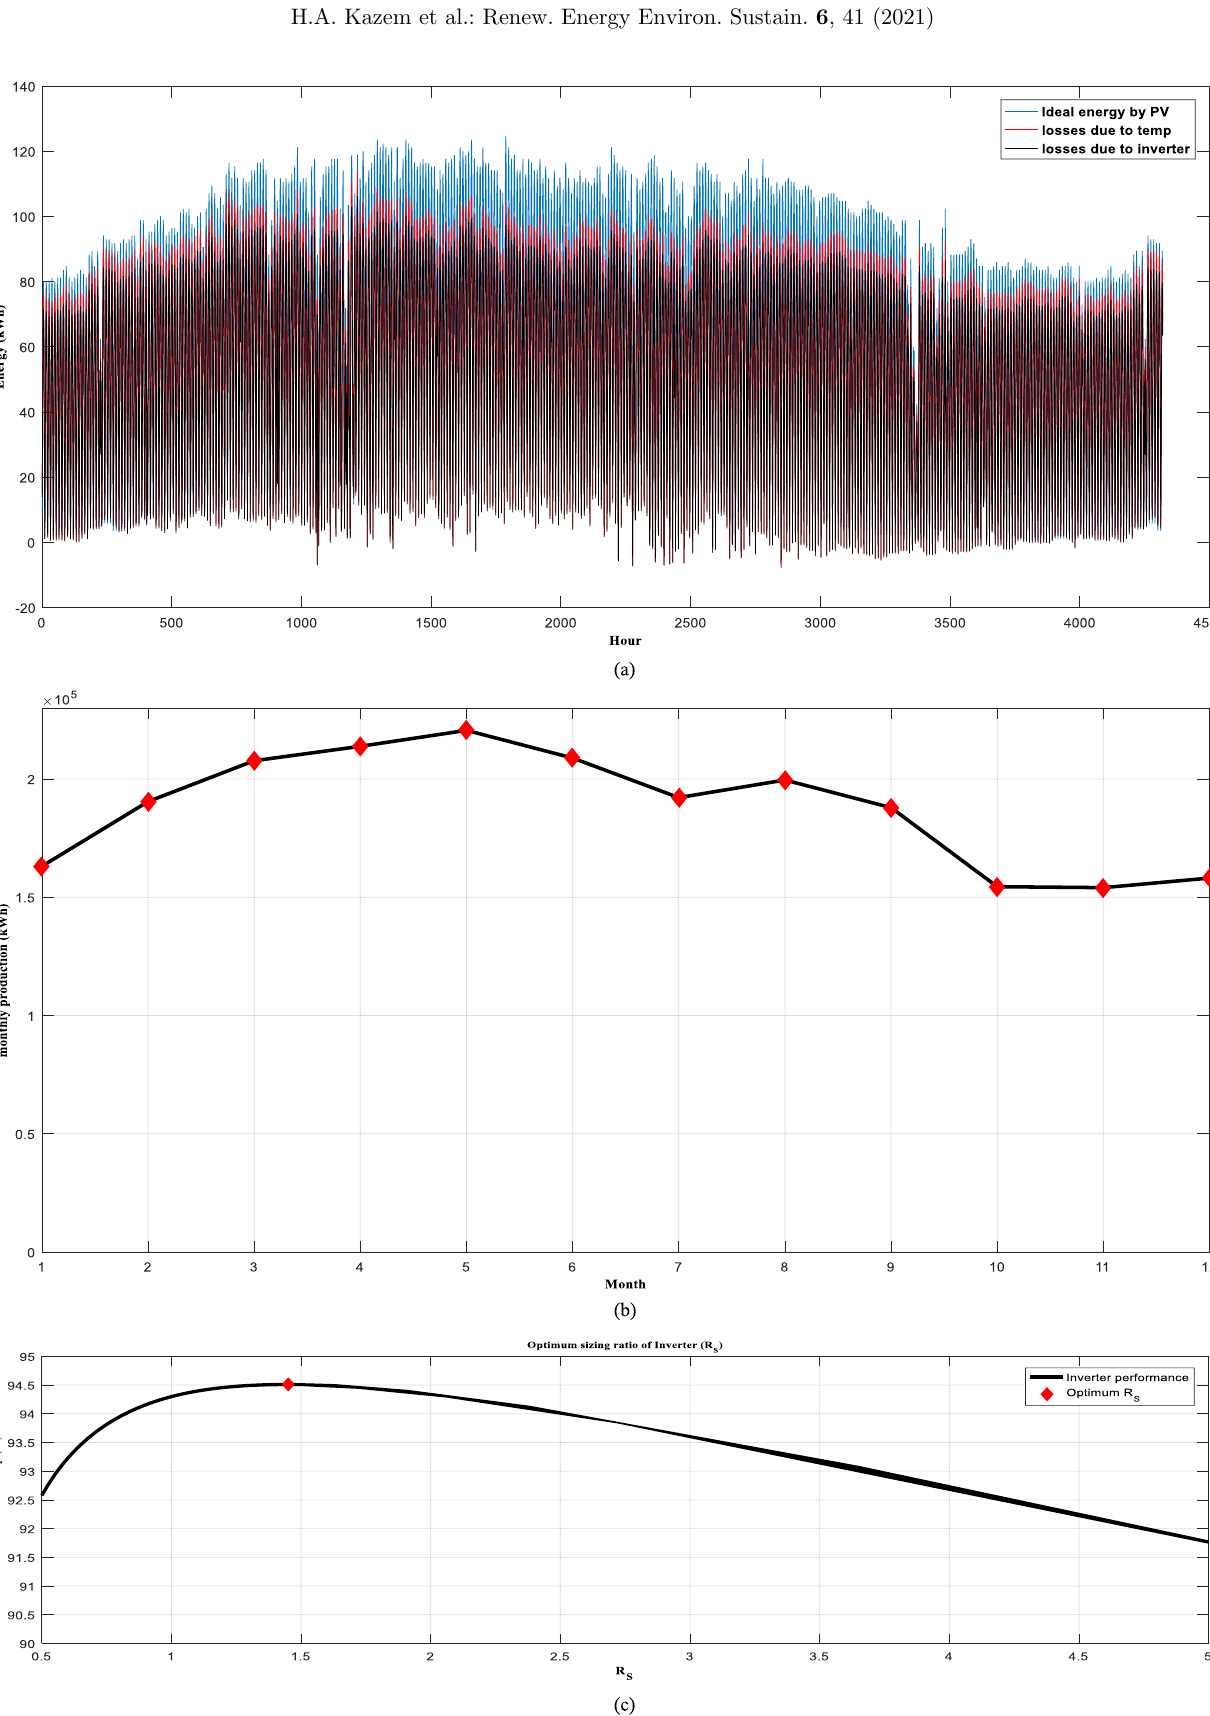
Fig. 4. SWPS performance and optimization results. (a) PV hourly energy production for one year (12 hours/day). (b) Monthly energy production. (c) Optimum